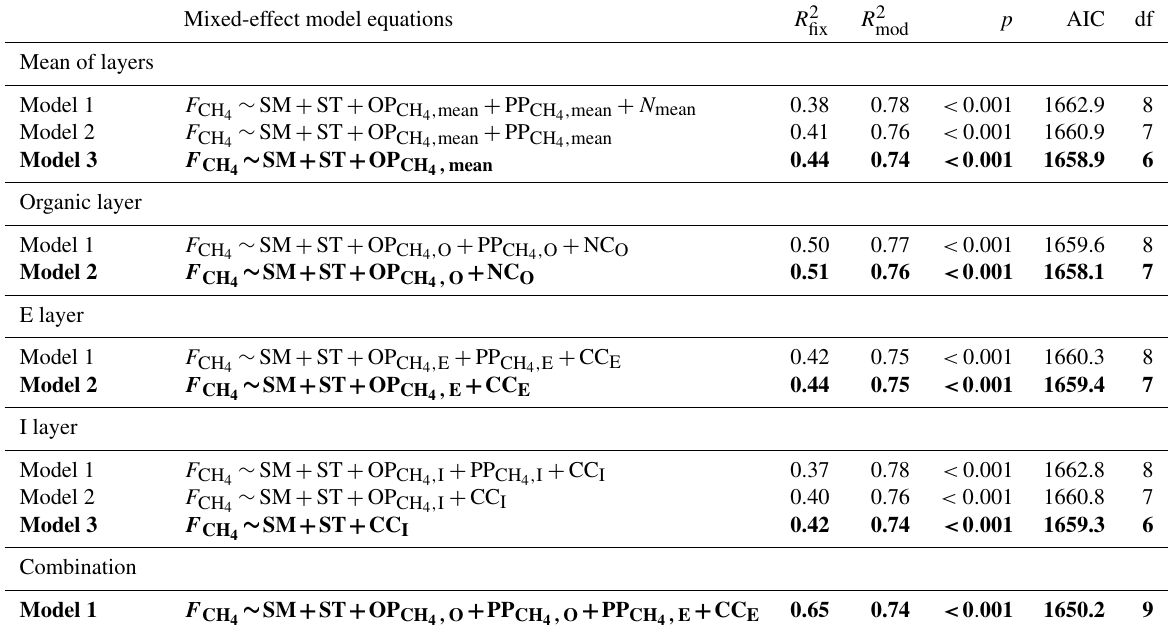
Table 1. Linear mixed-effect models fitted against CH 4 fluxes ( F CH ) and experimental factors. The fixed effects in the model were: SM 4 – 5cm soil moisture; ST – 5cm soil temperature; OP CH – CH 4 oxidation potential at soil layer x (O, E, I soil layers or the mean of all 4 ,x layers); PP CH – CH 4 production potential at soil layer x ; CC x – carbon content at soil layer x ; and NC x – nitrogen content at soil layer x . 4 ,x ) and the whole model (fixed effects + random effects, r 2 The table shows the r 2 of the fixed effects ( r 2 ), p value of the model ( p ), AIC fix mod of the model and the degrees of freedom (df). The models in bold are the best-fitted